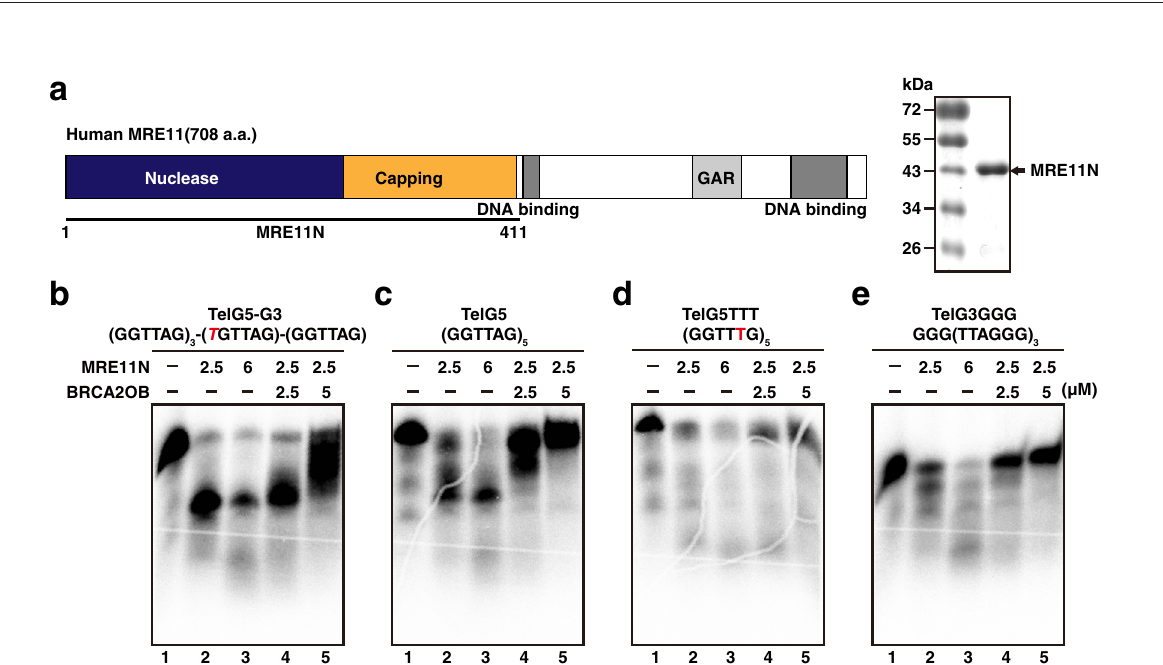
Fig. 4 BRCA2 recognizes G-triplex-derived intermediates. a An experimental scheme to observe BRCA2OB binding towards the dual-labeled TelG5-G3 construct that mimics the G3 intermediate structure. smFRET histograms for b TelG5-G3 and c TelG5TTT-G3: DNA alone (top) and upon incubation with 1 μ M BRCA2OB (bottom) with Gaussian fi ts (red). BRCA2OB-interacting states are fi lled in semi-transparent blue. Blue dashed line is the sum of the multiple Gaussian curves. One of the possible topologies of loop-associated G3:G4 (loop-G3:G4) and tail-associated G3:G4 (tail-G3:G4) are illustrated as a cartoon inside the histogram. Flanking tail sequences are underlined for each substrate at the top. d A schematic representation (left) of the molecular interaction between BRCA2OB and G4 structures during the direct NP-P transition. For reference, smFRET histograms of TelG5 (middle) and TelG5TTT (right) in the presence of 1 μ M BRCA2OB from Fig. 2g and Supplementary Fig. 7, respectively, are shown ( fi lled with gray). e EMSA to assess BRCA2OB binding to TelG5-G3, compared to TelG5 and TelG5TTT. TelG5GAG was employed as a negative control. Results are from the same gel. The experiments were repeated three times independently. f A model for BRCA2 binding to the G3 and G3:G4 intermediates during G4 conformational interconversions. Two possible G3:G4 conformations and one representative G3 structure that might form during the NP-P rearrangement without complete unfolding are shown. BRCA2 recognizes and binds to G3 intermediates, which reduce folding into G4.